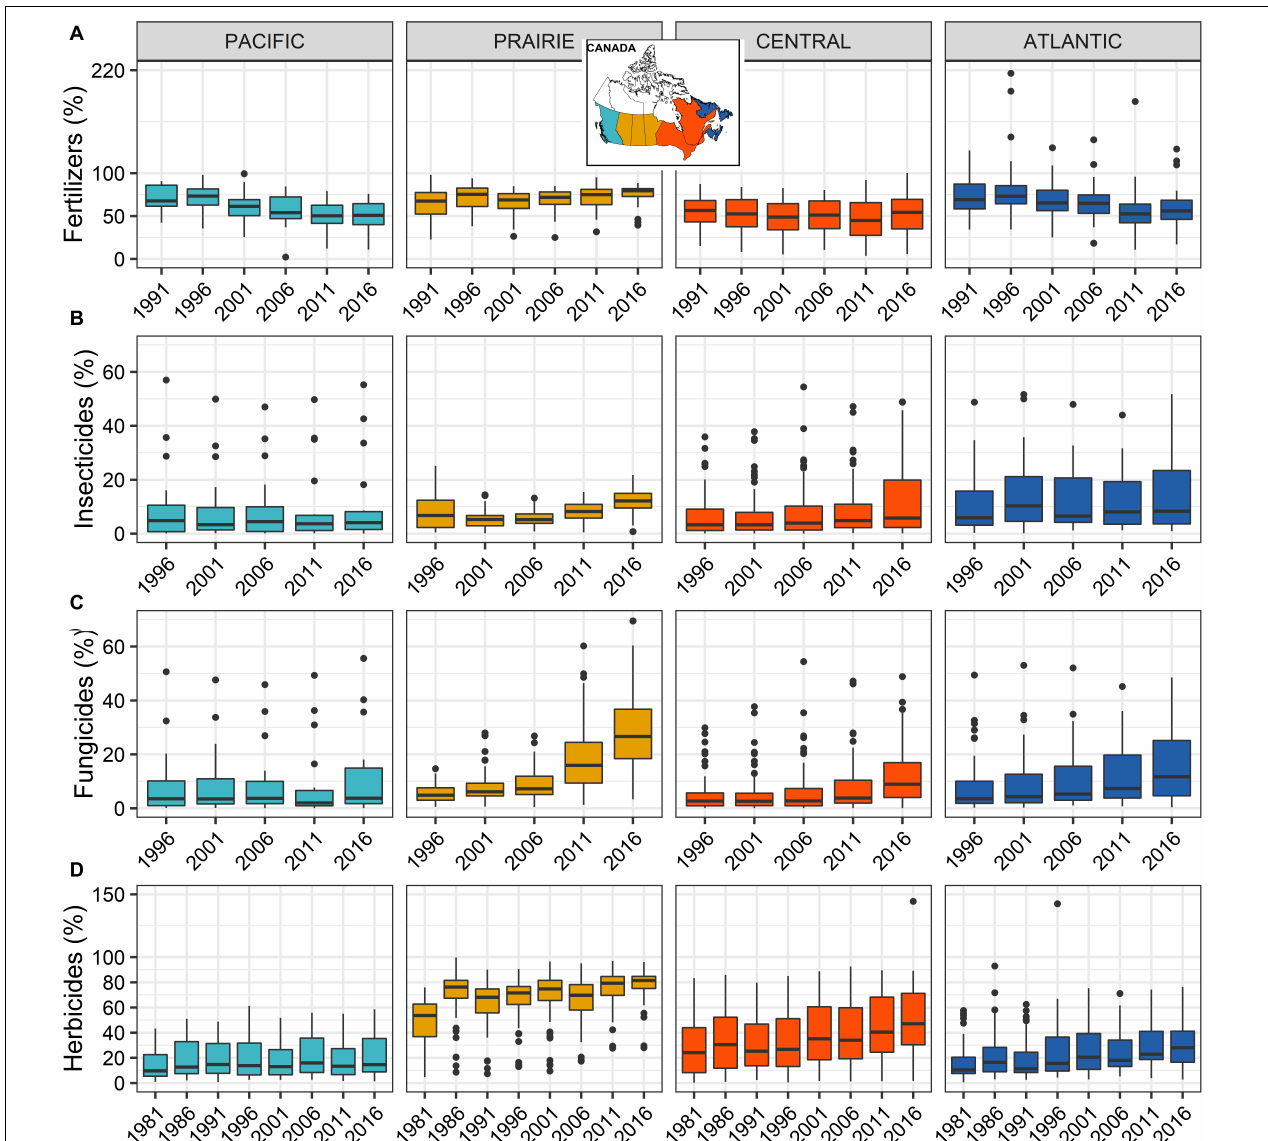
FIGURE 2 | Percent of the cropland treated with agrochemicals for each Census of Agriculture year and agricultural region in Canada. Agrochemicals include fertilizers (A) , insecticides (B) , fungicides (C) , and herbicides (D) , and the agricultural regions are ordered from west to east: British Columbia (Pacific; turquoise), Alberta, Saskatchewan and Manitoba (Prairie; orange), Ontario and Quebec (Central; red), and Nova Scotia, New Brunswick, Newfoundland/Labrador, Prince Edward Island (Atlantic; blue). Note that the date range of available data from the Census of Agriculture varies by agrochemical group: fertilizers